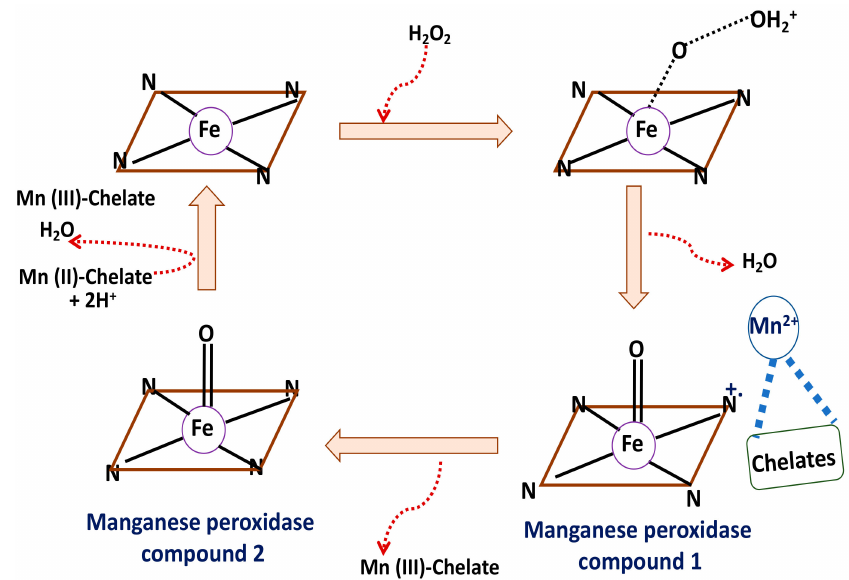
Figure 6. Schematic representation of the simplified mechanism of manganese